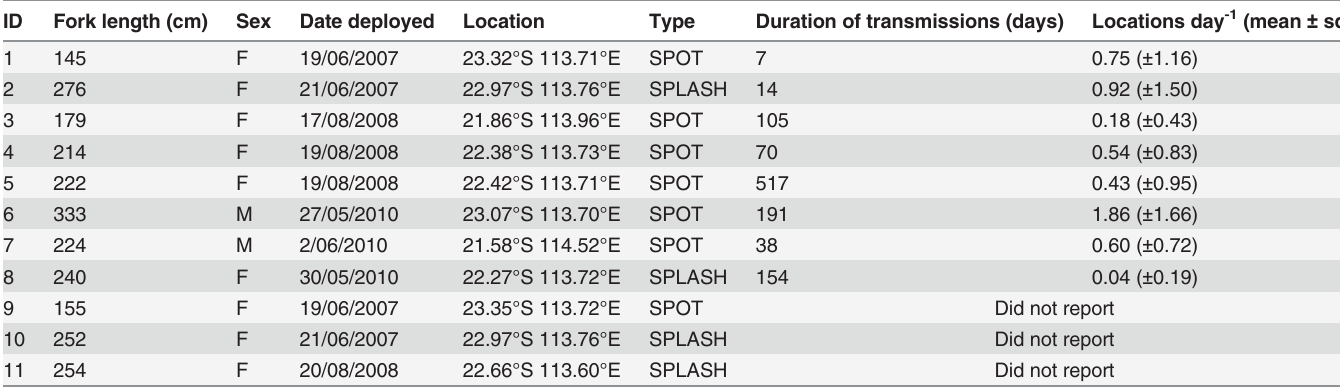
Table 1. Details of satellite transmitter deployments on tiger